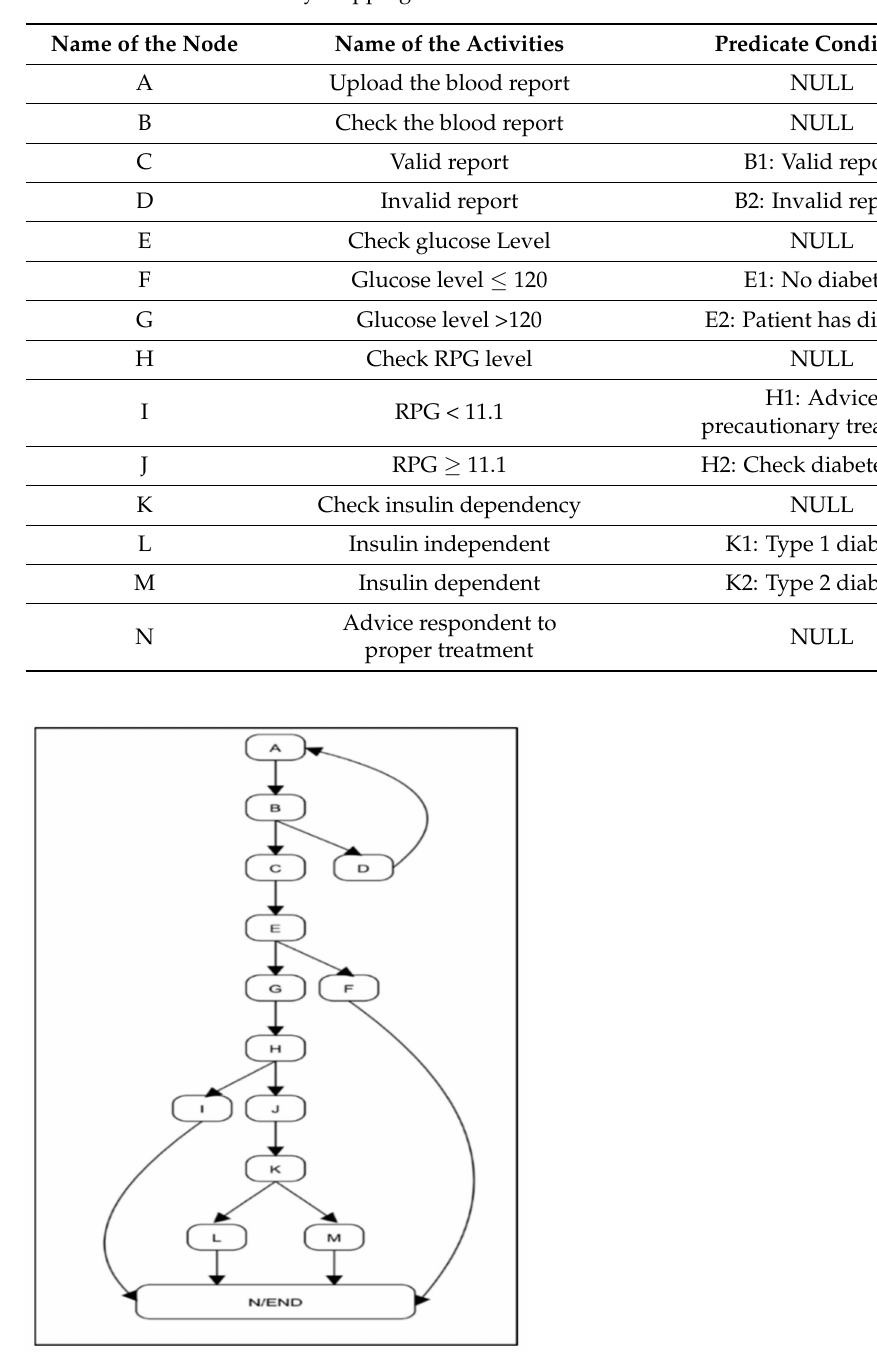
Table 2. Control flow activity mapping table.